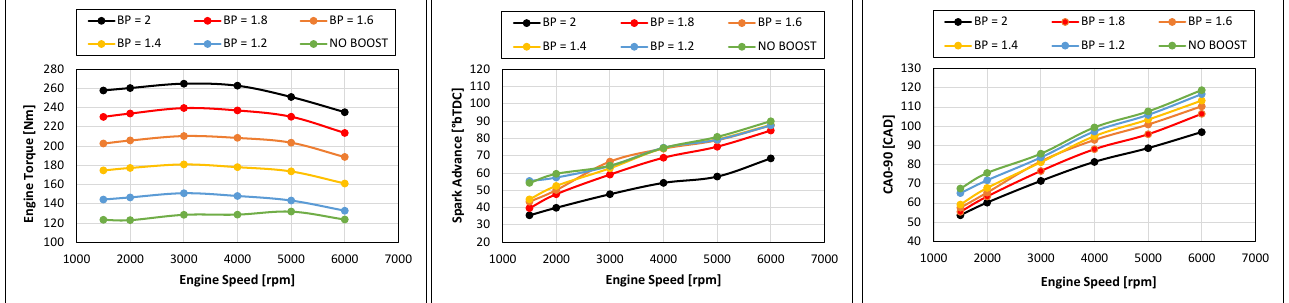
Figure 7. Engine torque ( left ) calculated at maximum torque knock limited spark advance ( middle ) and relative combustion duration ( right ) at different boost pressure levels.